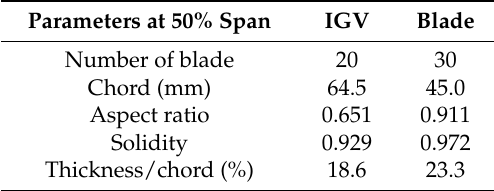
Table 2. Research turbine design geometry. Inlet guide vane (IGV).